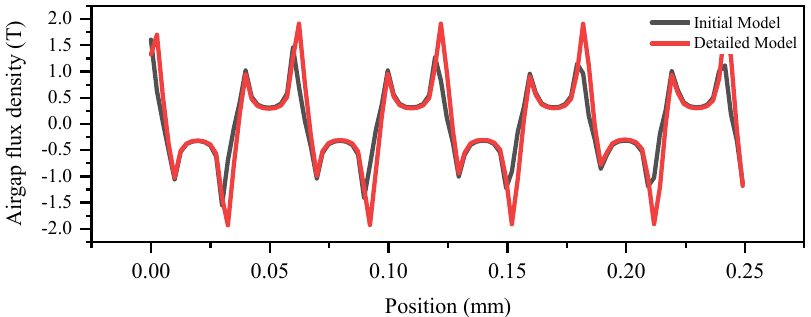
Figure 8. Flux density in the air ‐ gap at t = 0 s of the initial model and the detailed model.